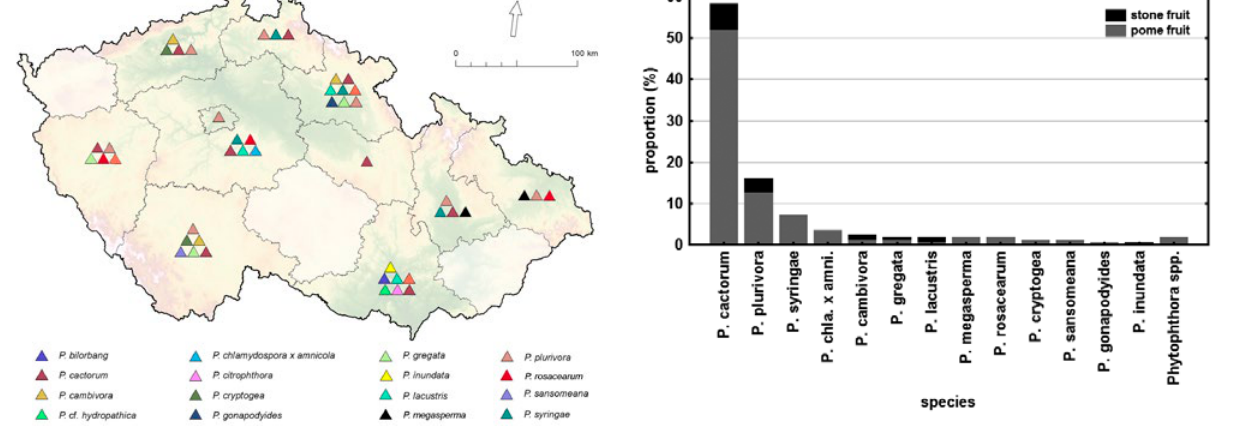
Figure 4. Frequency of occurrence of Phytophthora in fruit trees in the Czech